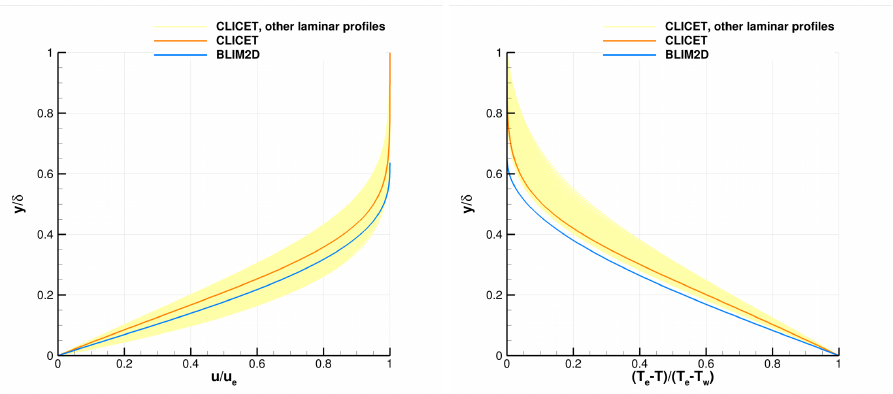
Figure 10. Velocity and temperature profiles produced by CLICET and BLIM2D in the Test Case RUN22a of Table 1, s / c = 0.087. ( Left ): velocity. ( Right ):